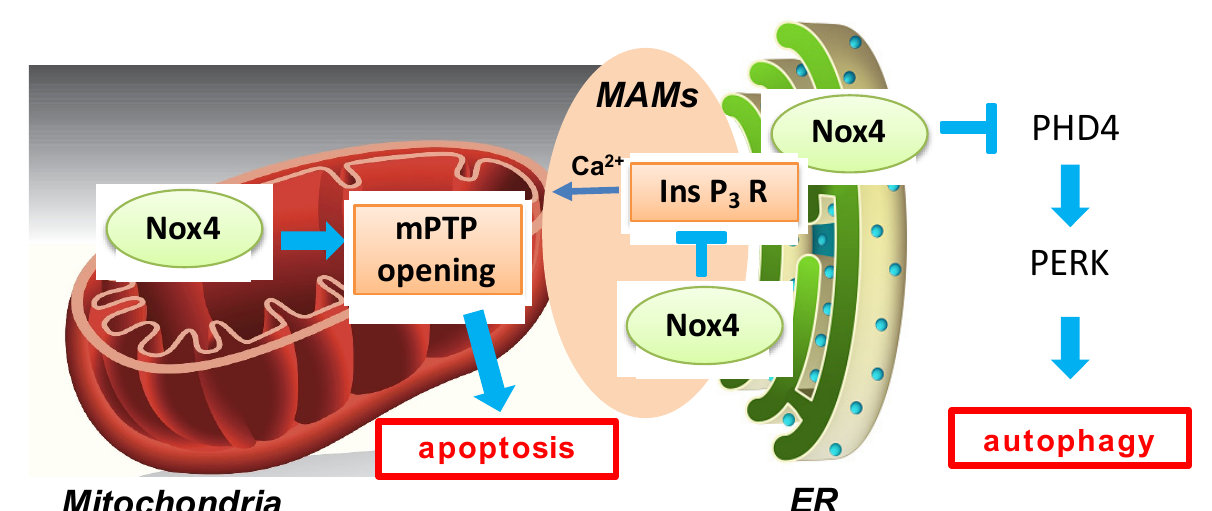
Figure 4. A schematic representation of multiple functions of Nox4-derived ROS during myocardial I/R injury. Mitochondrial Nox4 exerts a detrimental effect through ROS-induced mitochondrial dysfunction during I/R, whereas Nox4 on the ER membrane and at MAMs plays protective roles against I/R injury through regulation of autophagy and MAM function, respectively. Nox4 activates PERK by inhibiting PHD4 in ER. In addition, Nox4 suppresses calcium transfer from ER to mitochondria by inhibiting the Ins P 3 receptor.